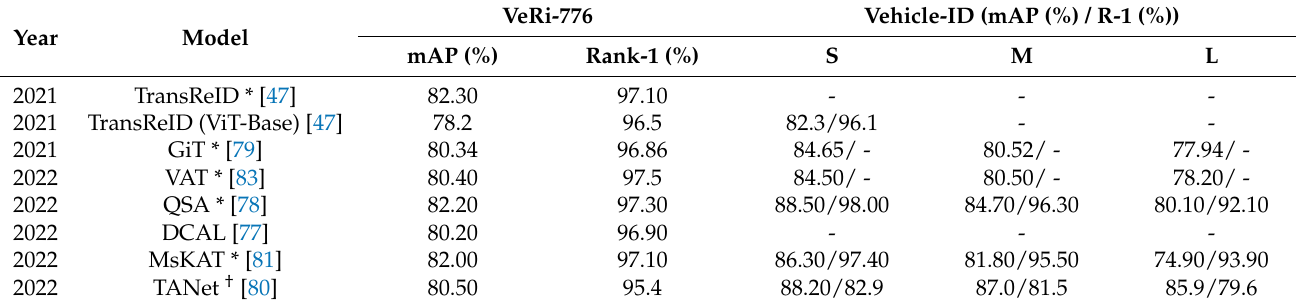
Table 4. Summary of some results on vehicle re-identification in a closed-set environment using Transformers on the VeRi-776 [3] and Vehicle-ID [25] datasets. * denotes methods using additional information, e.g., state or attribute information, and † methods detecting attribute information.